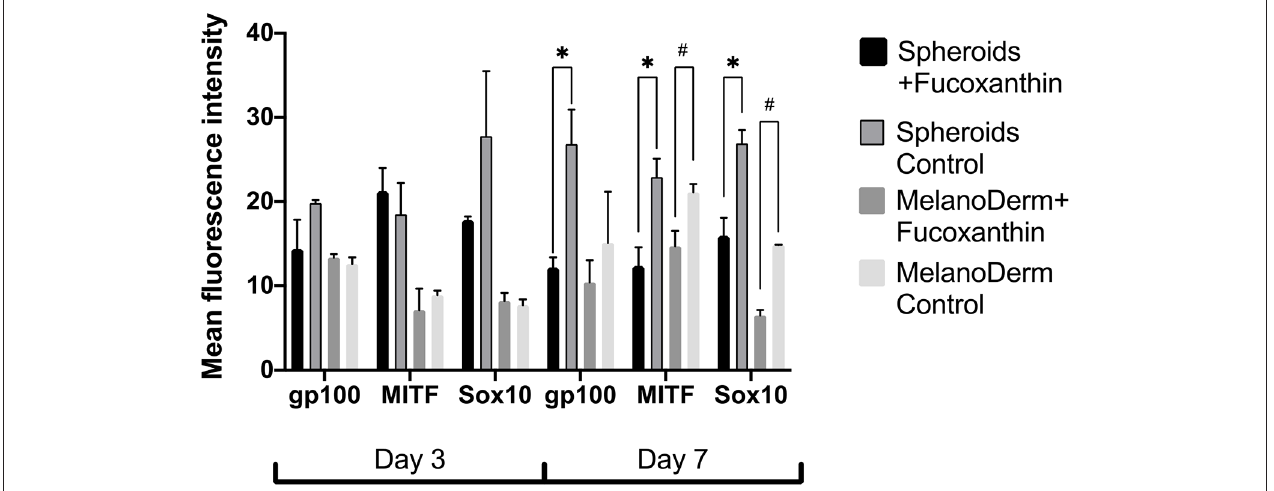
FIGURE 5 | The analysis of mean fluorescence intensity on the immunocytochemical staining images of spheroids and MelanoDerm TM sections in the experimental (in the presence of fucoxanthin) and control groups presenting an expression of gp100, MITF, and Sox10 on Days 3 and 7 in 3D culture. * # p < 0.05 for two-way ANOVA assay and multiple t -test.